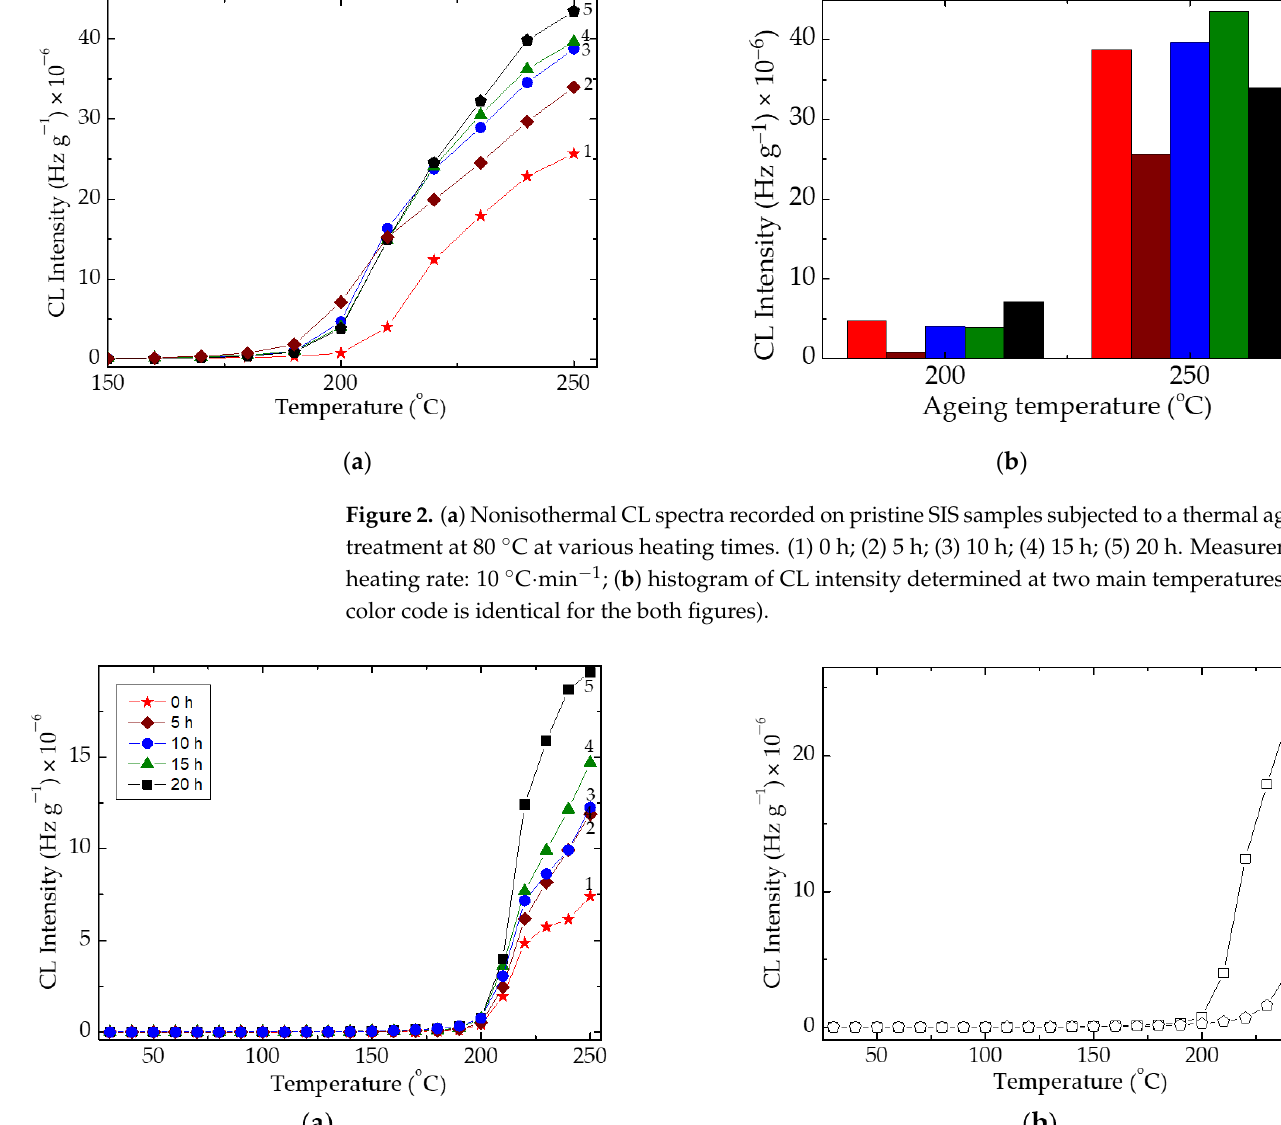
Figure 4. The nonisothermal CL curves recorded on the SIS samples improved by graphene (1 wt%)/rosemary (0.5 wt%) couple after their thermal ageing at 80 °C at various heating times. Heating rate: 10 °C min −1 . The thermal processing of the SIS matrix reveals an interesting peculiarity related to the evolution of CL emission, which follows the classical mechanism based on the radical reactions [71]. The formation of free radicals as the first effect of energetic transfer pro- vides reactive fragments that may react with diffused oxygen (oxidative degradation) or with each other (recombination). In the case of this polymer material, the oxidation is the